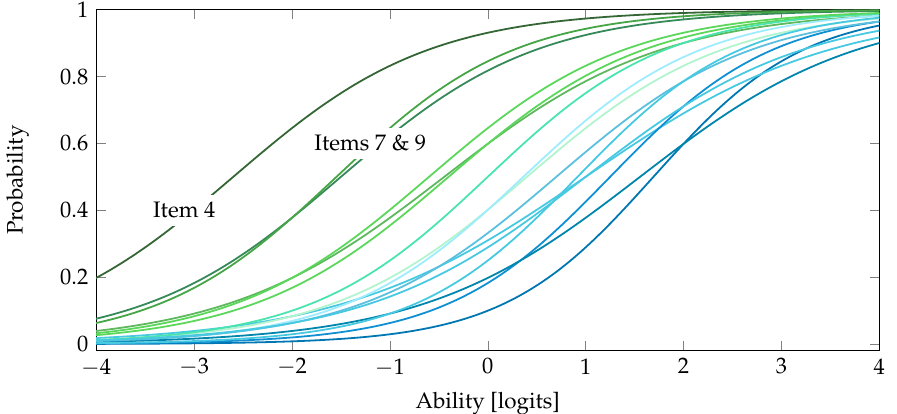
Figure 2. Item characteristic curves (ICC) for all items of the concept inventory. While the blue, light-blue, and light-green curves correspond to items that show good fit to the Rasch model, the outliers, namely items 4, 7, and 9, can also be identified. This observation is further substantiated analyzing the Wright Map presented in Figure